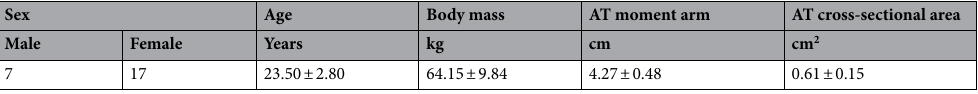
Table 4. Subject morphometrics and summary statistics. Subject morphometrics and statistics presented as the number of males and females and all numeric variables represent the mean and the standard deviation (AT: Achilles